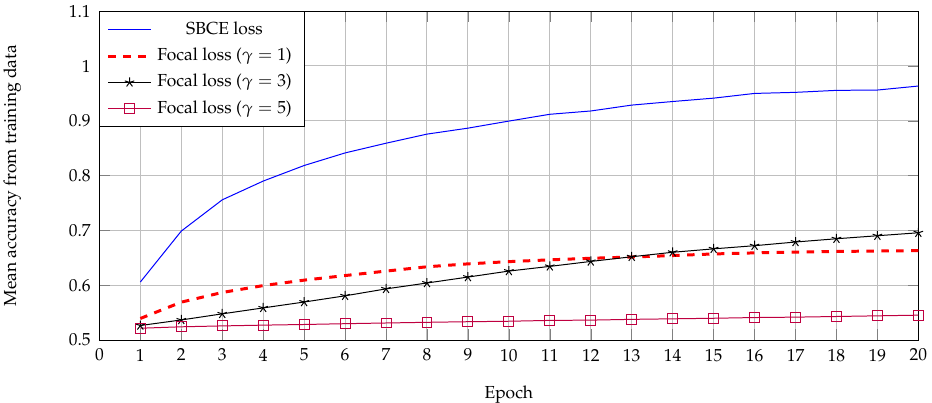
Figure 6. Mean accuracy from training data by using stable binary cross-entropy and focal losses with various values of γ .